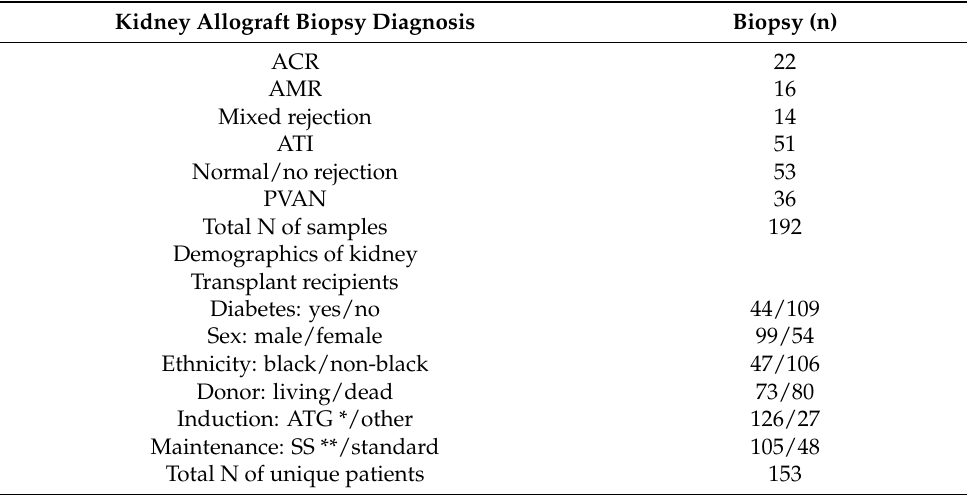
Table 1. Summary of sample characteristics and patient demographics. Additional details are provided in Tables S1 and